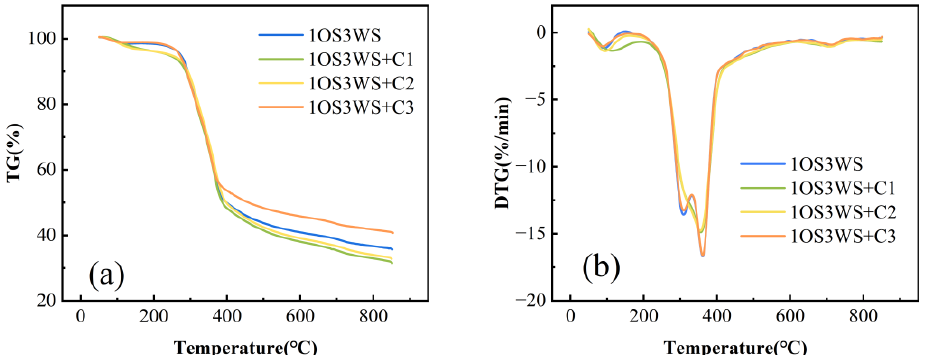
Figure 5. TG ( a ) and DTG ( b ) curves of the mixture of oily sludge and walnut shell under different catalyst conditions. catalyst